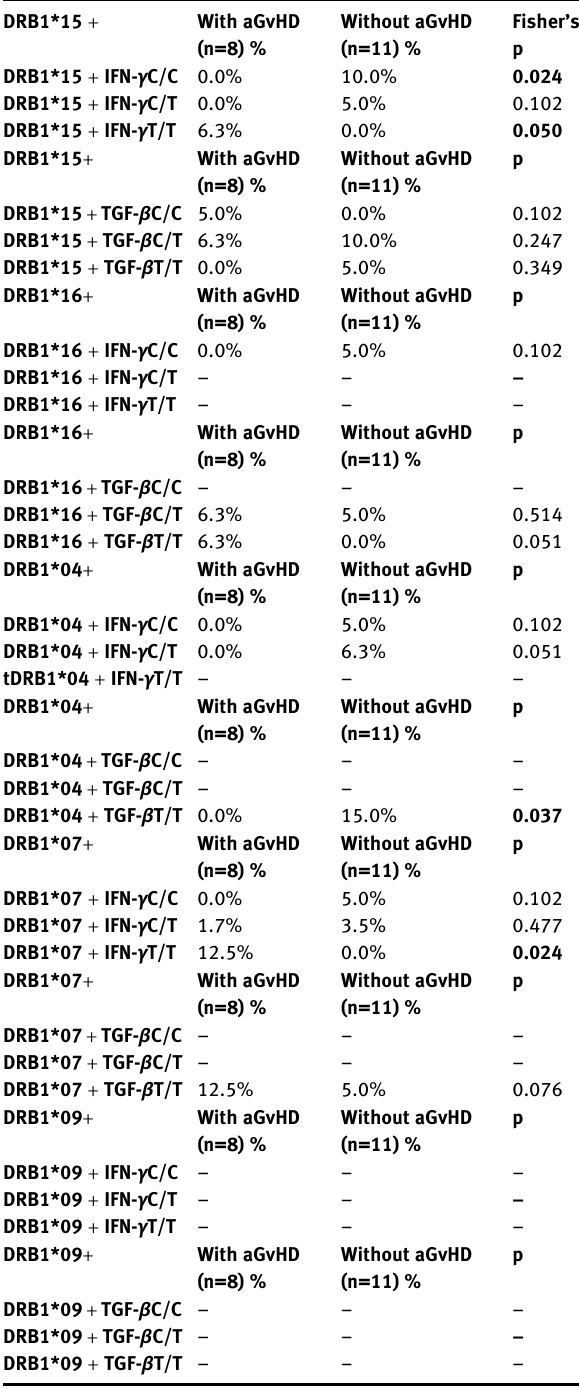
Table  : ComparisonoftheHLA-DRB  *  ,  ,  ,  ,  allelesand the association with the TGF- β , IFN- γ variations in the patients and control.